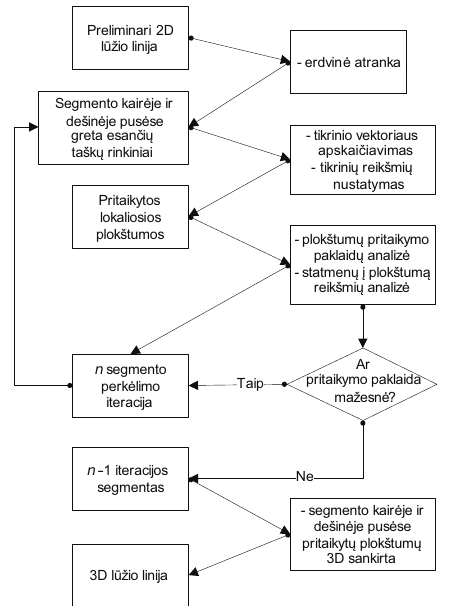
Fig. 3. The algorithm of approximate line